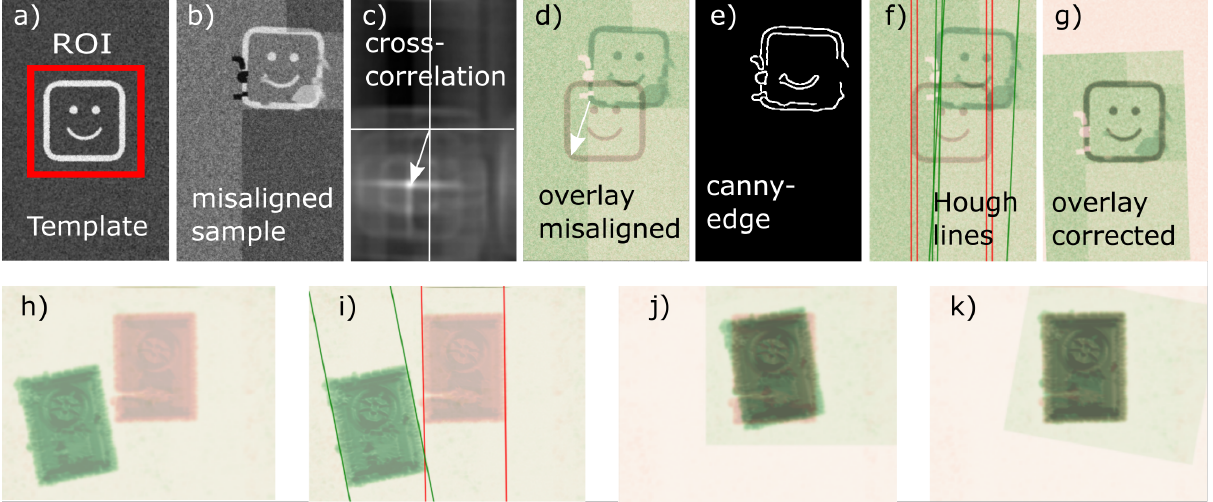
Figure 6. ( a – g ) Image-processing steps shown on test images. ( a ) Template: the structure of interest is in correct position and is selected as region of interest (ROI). ( b ) Misaligned sample: Test image containing the structure of interest at a different position and a variety of image distortions (e.g., noise or bad pixels). ( c ) Cross-correlation of the ROI with the misaligned sample. The white arrow indicates the in-plane displacement. ( d ) Overlay of the template and the misaligned sample. The white arrow again indicates the displacement. ( e ) Edge detection with canny edge algorithm on the misaligned sample. This is also applied to the template. ( f ) Hough line detection is applied to both edge images, with the results displayed as an overlay image. These are used for calculating the angular displacement. ( g ) Corrections in terms of linear and angular displacement lead to a perfect overlay of template and previously misaligned sample. ( h – k ) Application on real measured data. ( h ) Overlay of template (red) and misaligned sample (green). ( i ) Angular misalignment detected by Hough lines. ( j ) Correction of linear displacement only. ( k ) Linear and angular displacement correction, leading to perfect